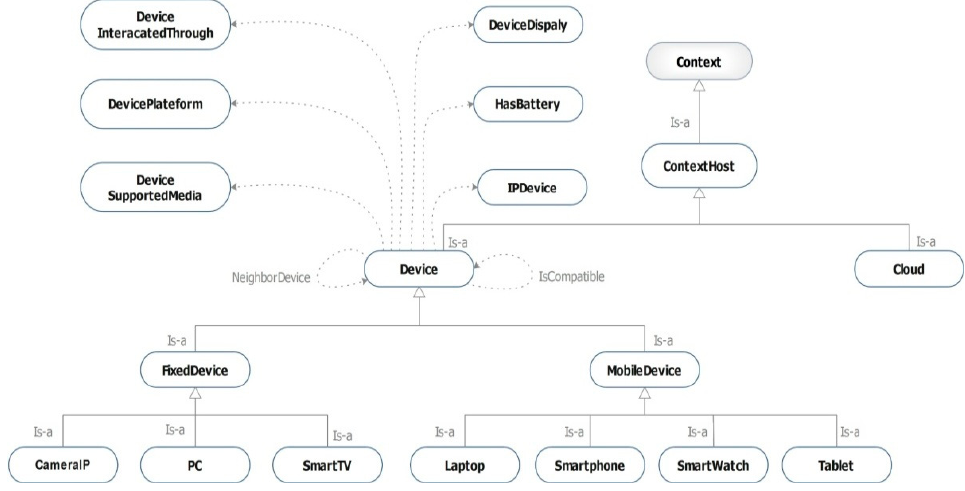
Figure 7. Hard context sub ‐ ontology.